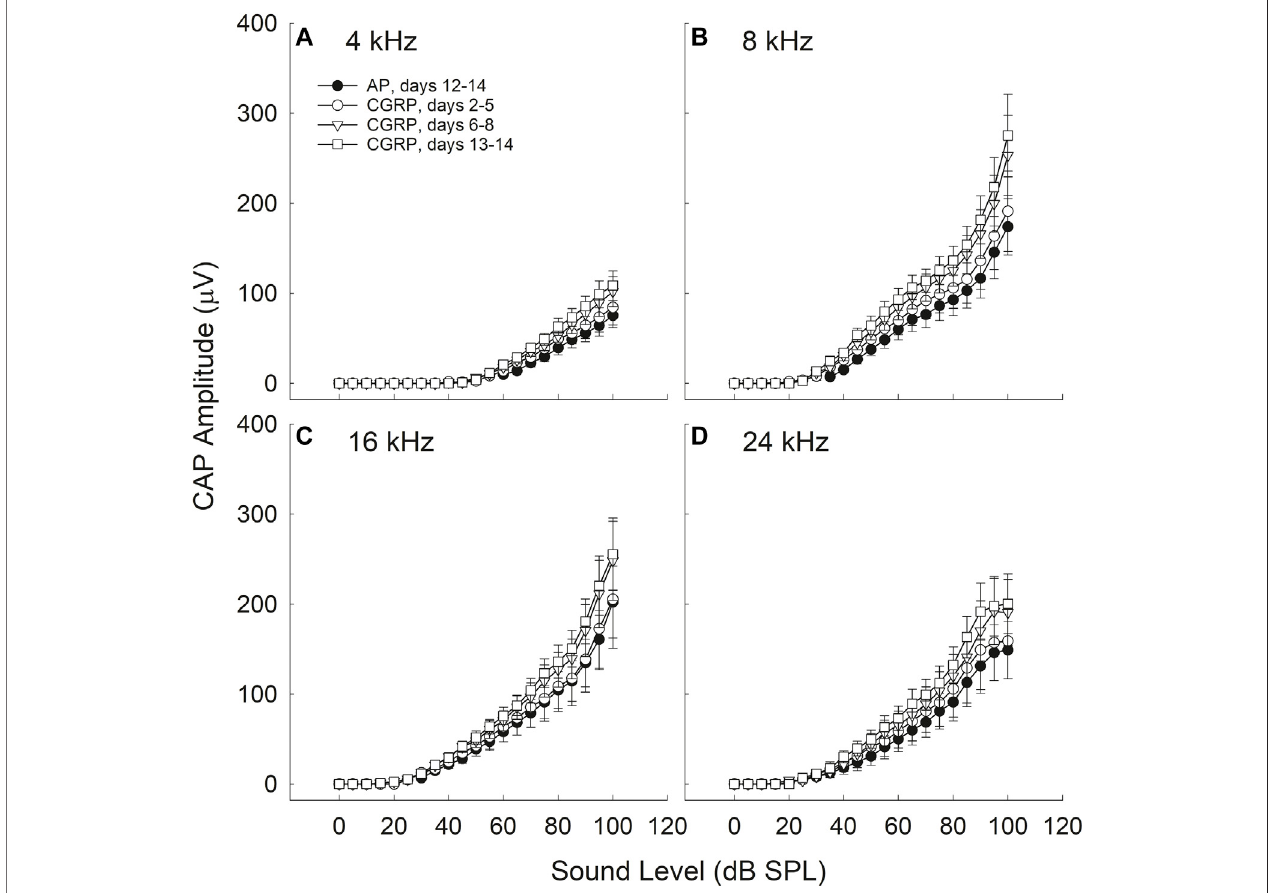
FIGURE 2 | CAP amplitude increased during CGRP infusion; all comparisons are relative to control measurements on the 12th-14th day of arti fi cial perilymph (AP) infusion, immediately prior to the pump change surgery during which the AP pump was replaced with a pump containing CGRP. Increases in CAP amplitude (30 – 35%) werestatisticallyreliableat4 (A) ,8 (B) ,16 (C) ,and24 (D) kHzfortheCGRP(days13 – 14)comparisonswiththeAPdataset(all p ‘ s < 0.005).CGRP-inducedchangesare shown as a function of duration of infusion; tests were conducted at least once from days 2 – 5, on days 6, 7, or 8, and on days 13 or 14.